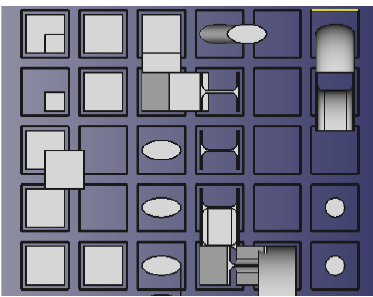
Figure 7. Example of appearance of geometries in